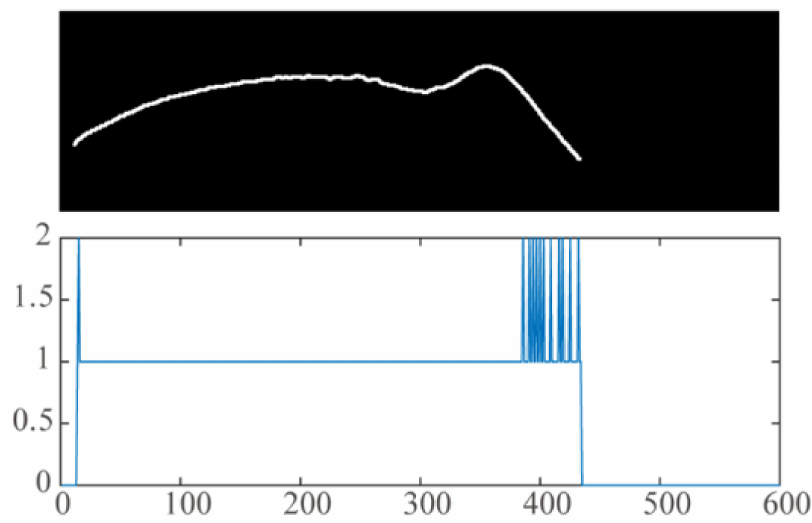
Figure 2. A binary discharge curve image ( upper ) and its vertical projection diagram ( below ).